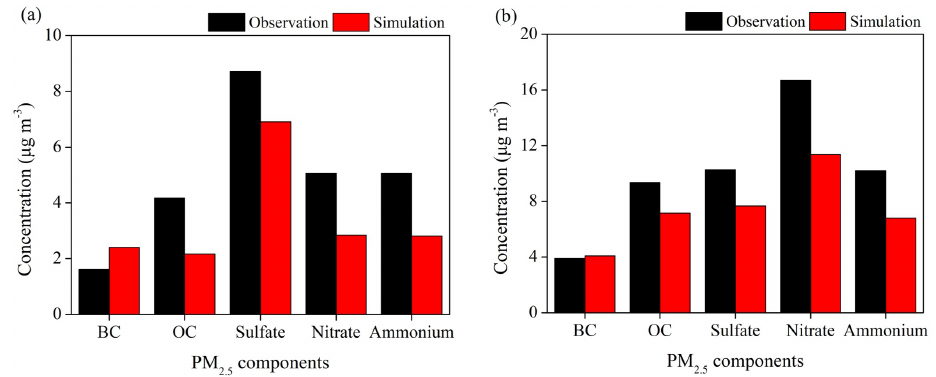
Figure 3. Comparisons of surface PM 2 . 5 components from WRF-Chem simulations and observations in Period I (a) and Period II (b) at the four supersites in YRD.